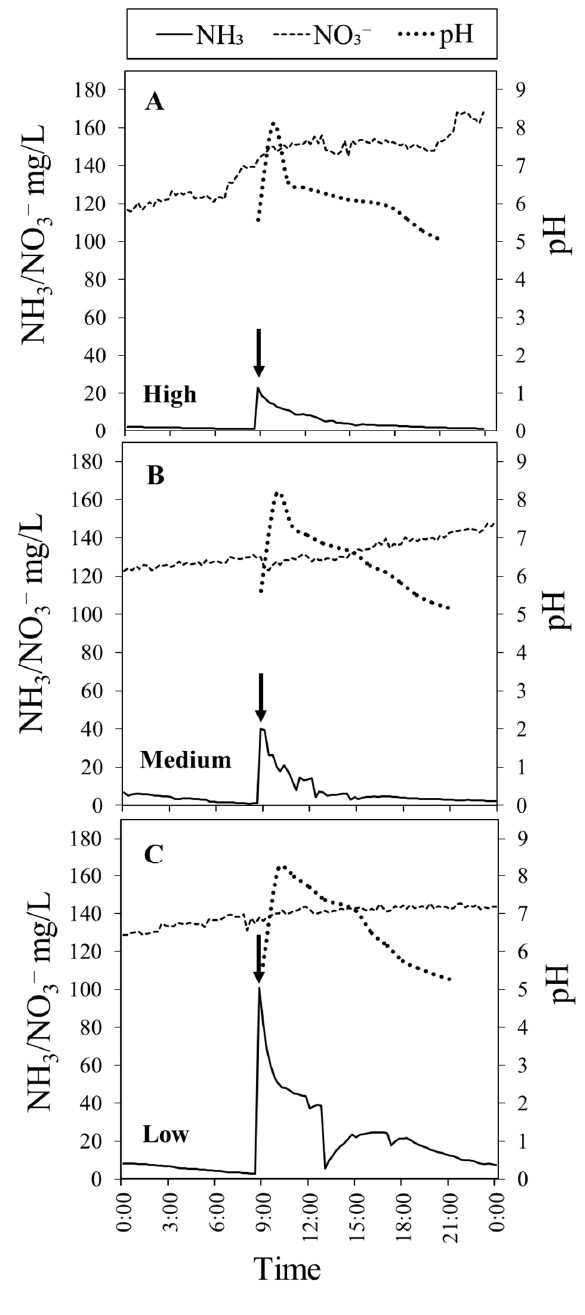
Figure 4. ( A – C ) Dynamic changes in ammonia (NH 3 ; solid line), nitrate (NO 3 − ; dashed line), and pH (dotted line) over 24 h as affected by high (3.3 m/day), medium (2.2 m/day), and low (1.1 m/day) flow rate treatments, which were measured in the absence of plants. Arrow indicates the time when fish feed (0.5% fish fresh weight) was applied to the fish tank. Data represent the mean of 3 replicates.